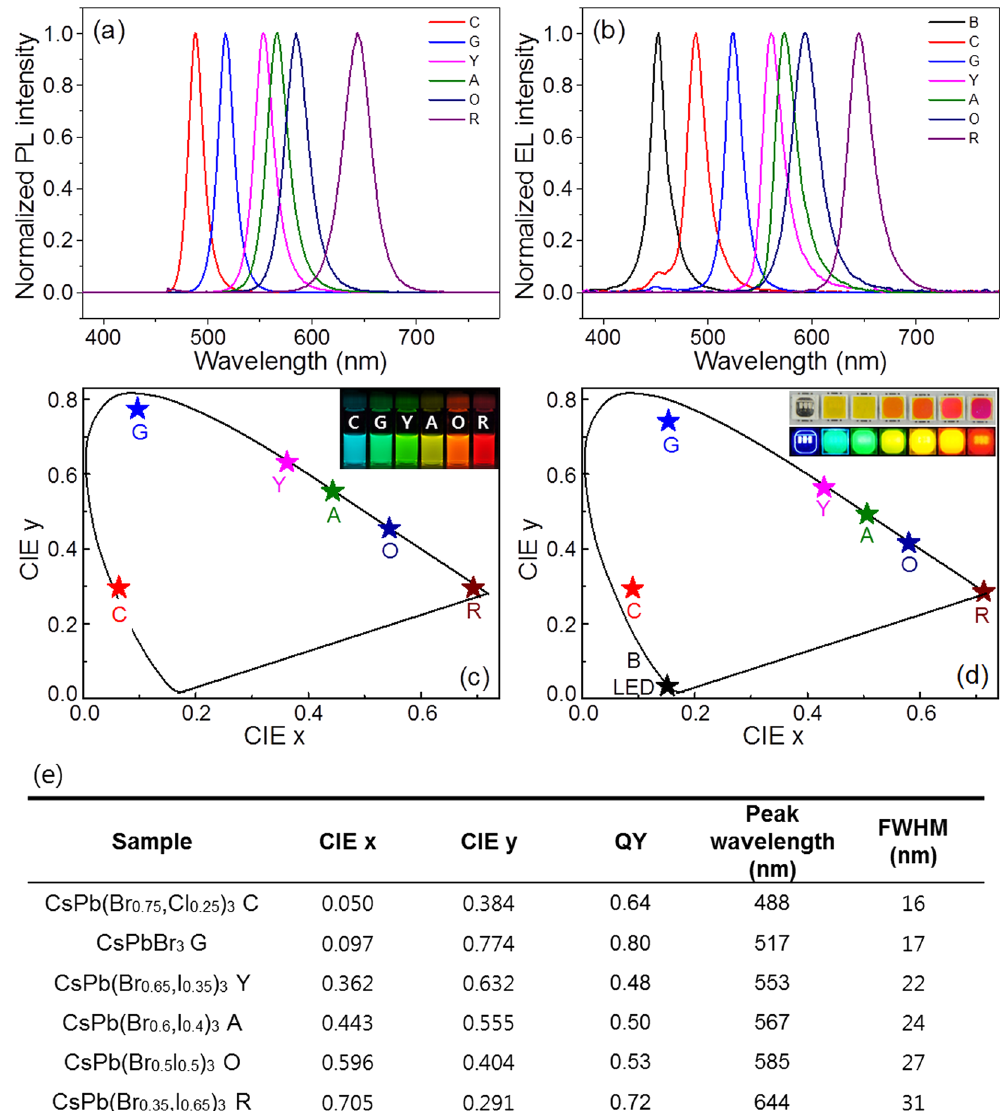
Figure 3. ( a ) PL spectra of CGYAOR-emitting CsPb(Br 1 − x , X x ) 3 PeQDs and ( b ) EL spectra of PeQD-based CGYAOR-emitting monochromatic DC-LEDs and InGaN B-chip LEDs. CIE color coordinates of ( c ) PeQDs and ( d ) PeQD-based monochromatic DC-LEDs. The insets of ( c ) and ( d ) show emission photographs of the six-color colloidal PeQDs and LPDF-capped PeQD package DC-LEDs. ( e ) Optical properties of colloidal CsPb(Br 0.75 , Cl 0.25 ) 3 cyan, CsPbBr 3 green, CsPb(Br 0.65 , I 0.35 ) 3 yellowish green, CsPb(Br 0.6 , I 0.4 ) 3 yellow, CsPb(Br 0.5 , I 0.5 ) 3 orange, and CsPb(Br 0.35 , I 0.65 ) 3 red